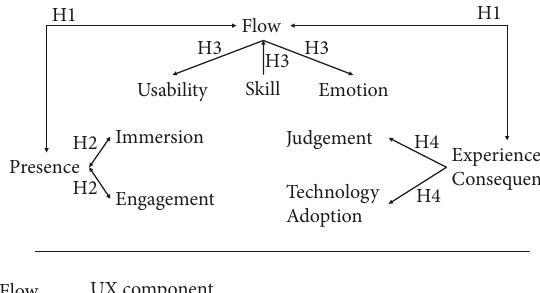
Figure 1: The hypothesized UXIVE